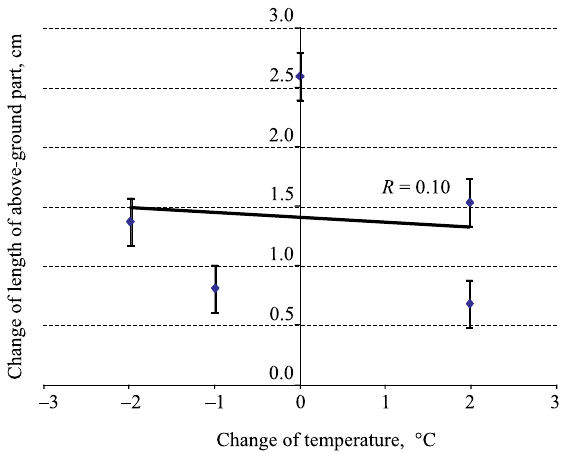
Fig. 14. Change of length of above-ground part of crimson clover dependence on change of temperature